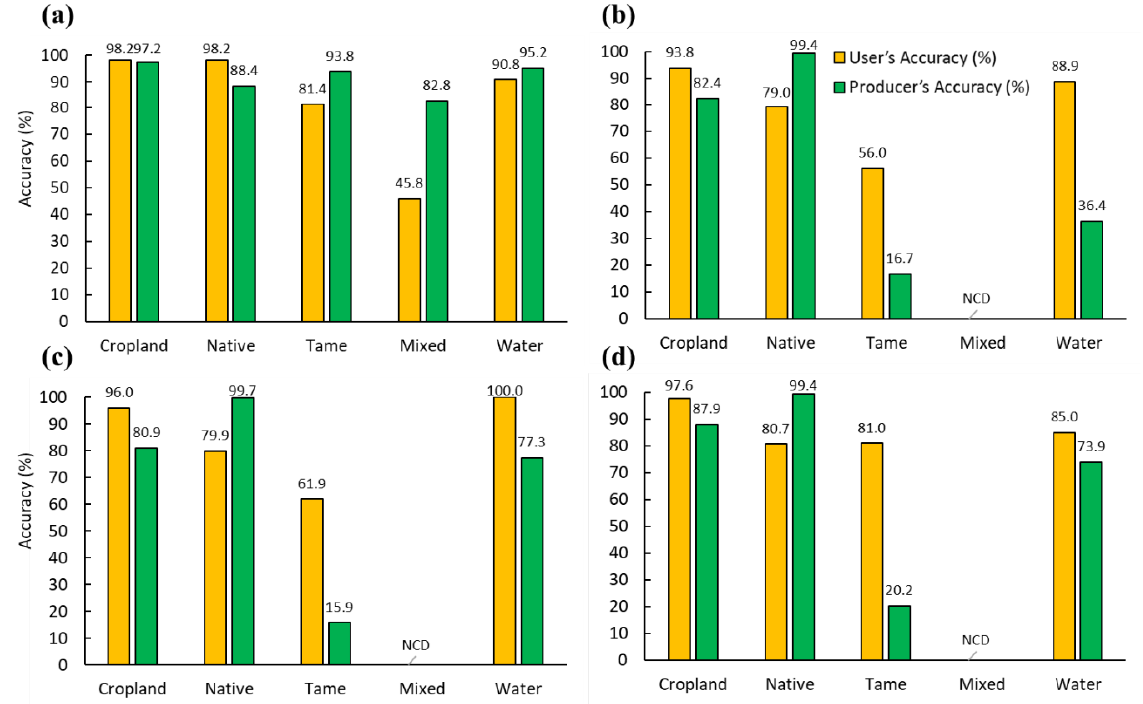
Figure 5. The accuracy assessment of the MGE classification, User’s Accuracy (%): This value represents the probability of a classified pixel into a given category represents that category on the ground, and the Producer’s Accuracy (%): This value represents how well reference pixels of the ground cover type are classified; ( a ) PLI classification; ( b ) AAFC 2017; ( c ) AAFC 2018; and ( d ) AAFC 2019.